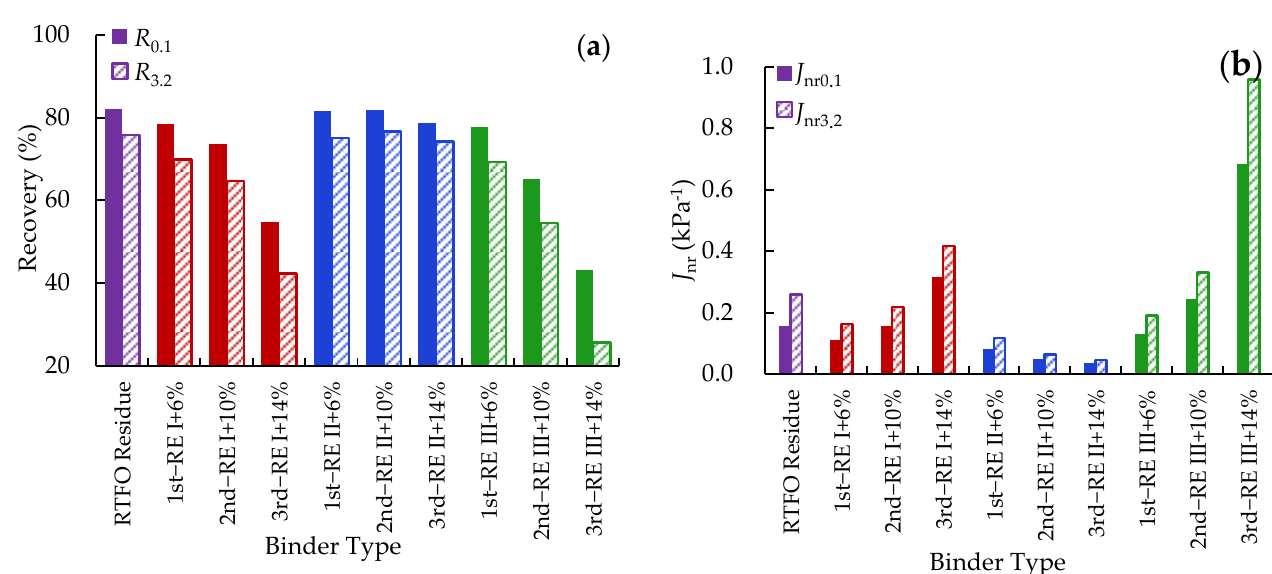
Figure 7. MSCR rutting evaluation of the repetitively rejuvenated asphalt-binders: ( a ) Recovery; ( b ) non-recoverable creep compliance ( J nr ) (Red bars: the asphalt-binders rejuvenated with Type I; blue bars: the asphalt-binders rejuvenated with Type II; green bars: the asphalt-binders rejuvenated with Type III).